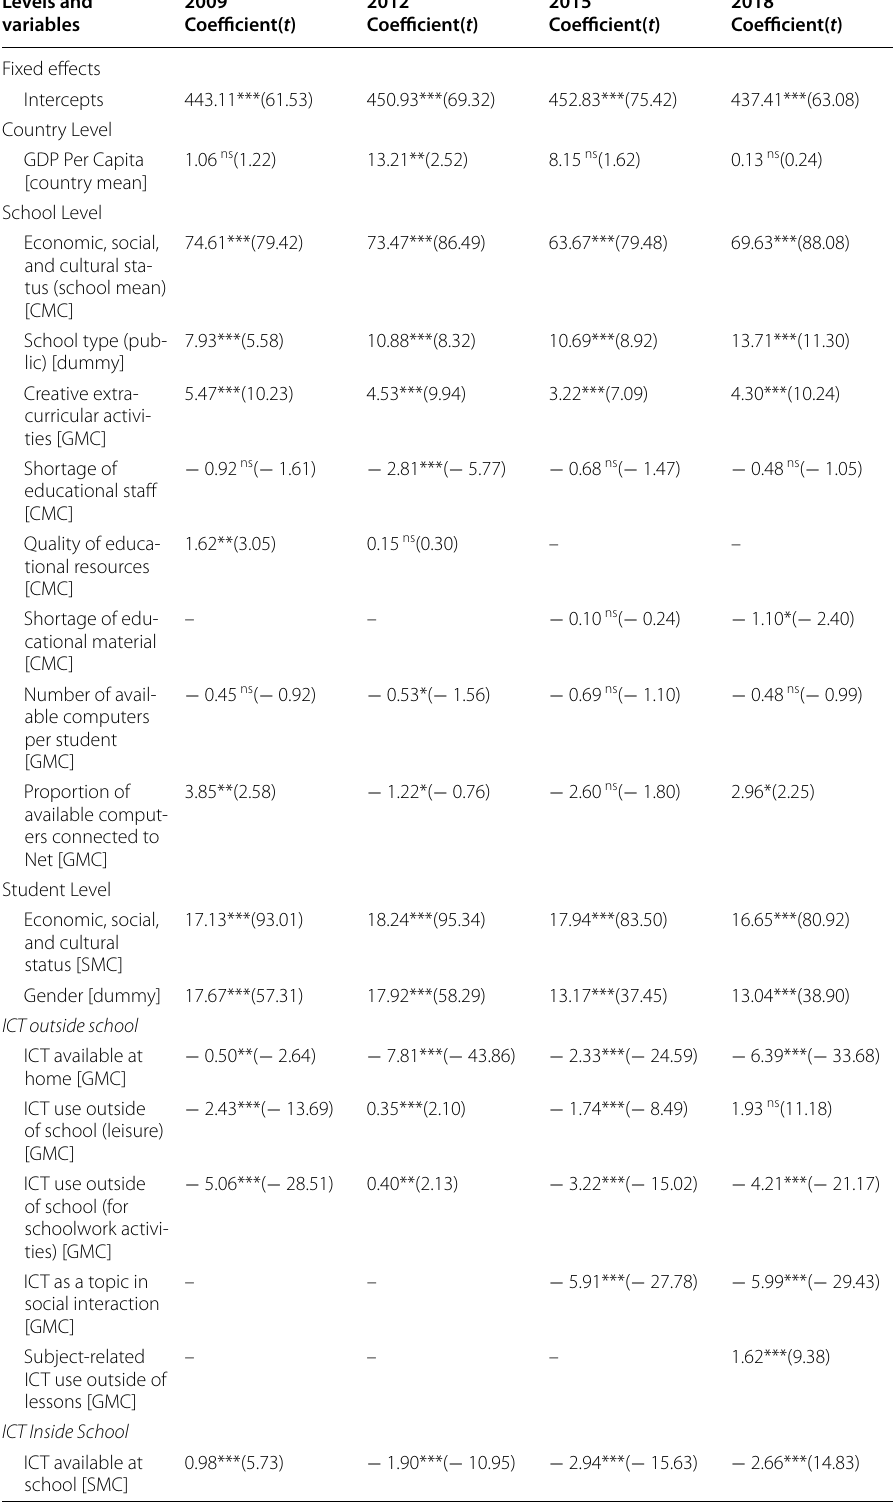
Table 3 Mixed Effects Model for Students’ Mathematics Ability Levels and